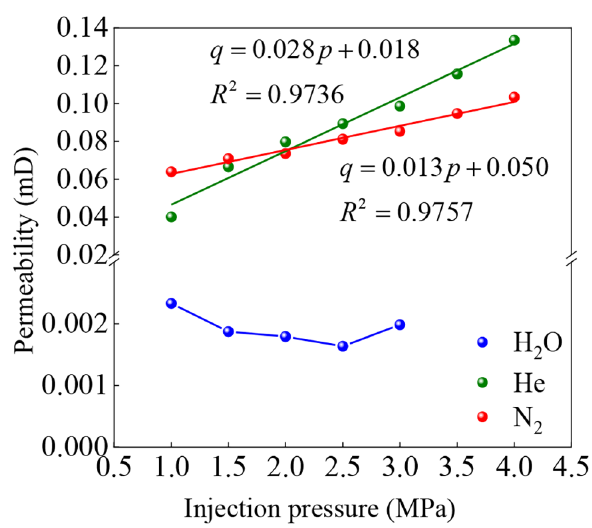
Fig. 9 Permeability versus radial strain during gas injection and water injection Fig. 8 Permeability versus injection pressure during gas injection and